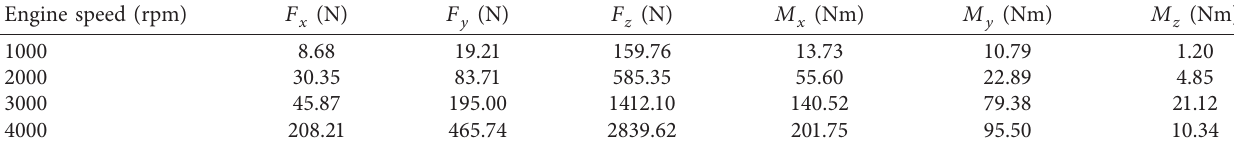
Table 7: Second-order excitation forces identified by the mount deformation method (in the powertrain centroid coordinate system). Engine speed (rpm)